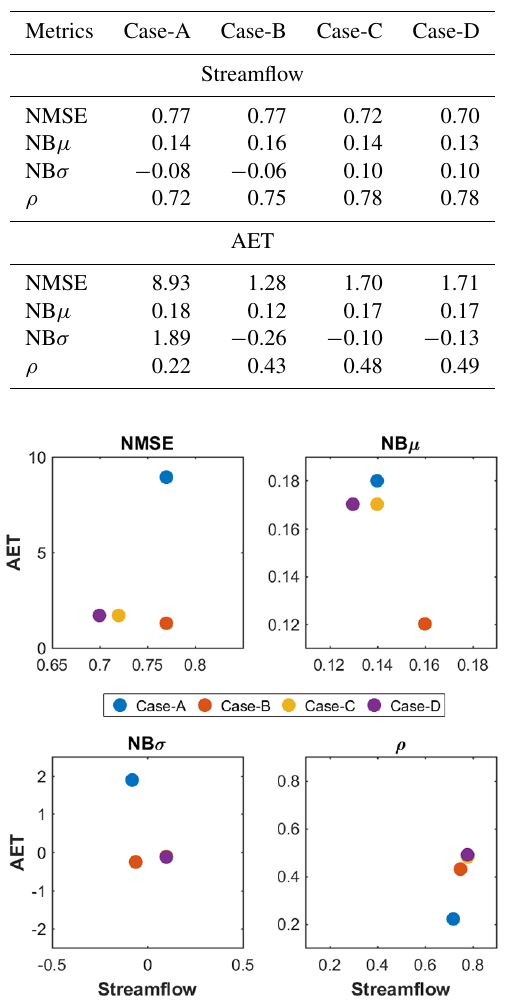
Figure 9. Streamflow and AET error statistics in total simulation for all four cases in Stage-II Step-1